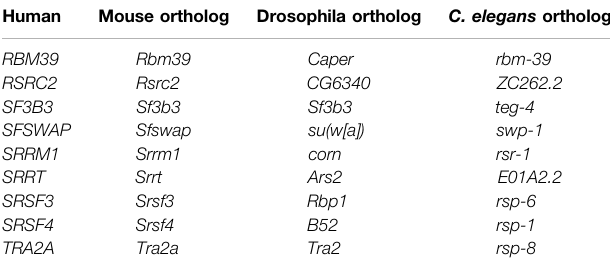
TABLE 5 | AS-NMD regulated genes conserved across the